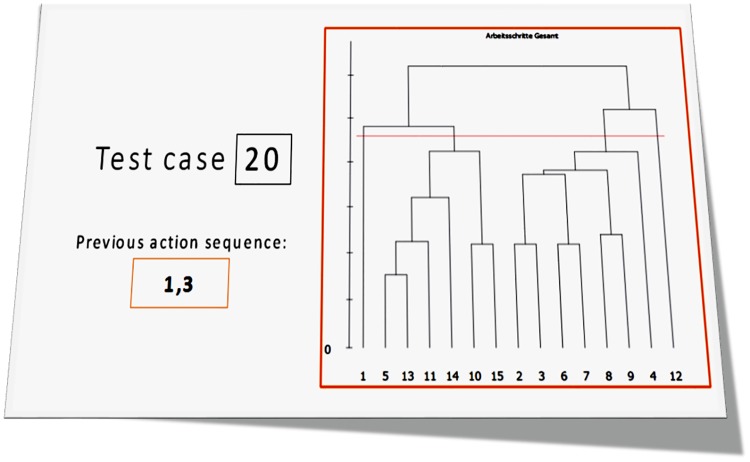
Example of a test case representing a fictitious “situation” for assessment.The right side shows a dendrogram visualizing a subject’s mental representation structure for the kiosk service activities. In this example some actions from the “kiosk preparation” activity (IDs 2, 3 and 4) are clustered with actions from the “customer service” activity (IDs 6, 7, 8 and 9), indicating a corresponding relation in memory.